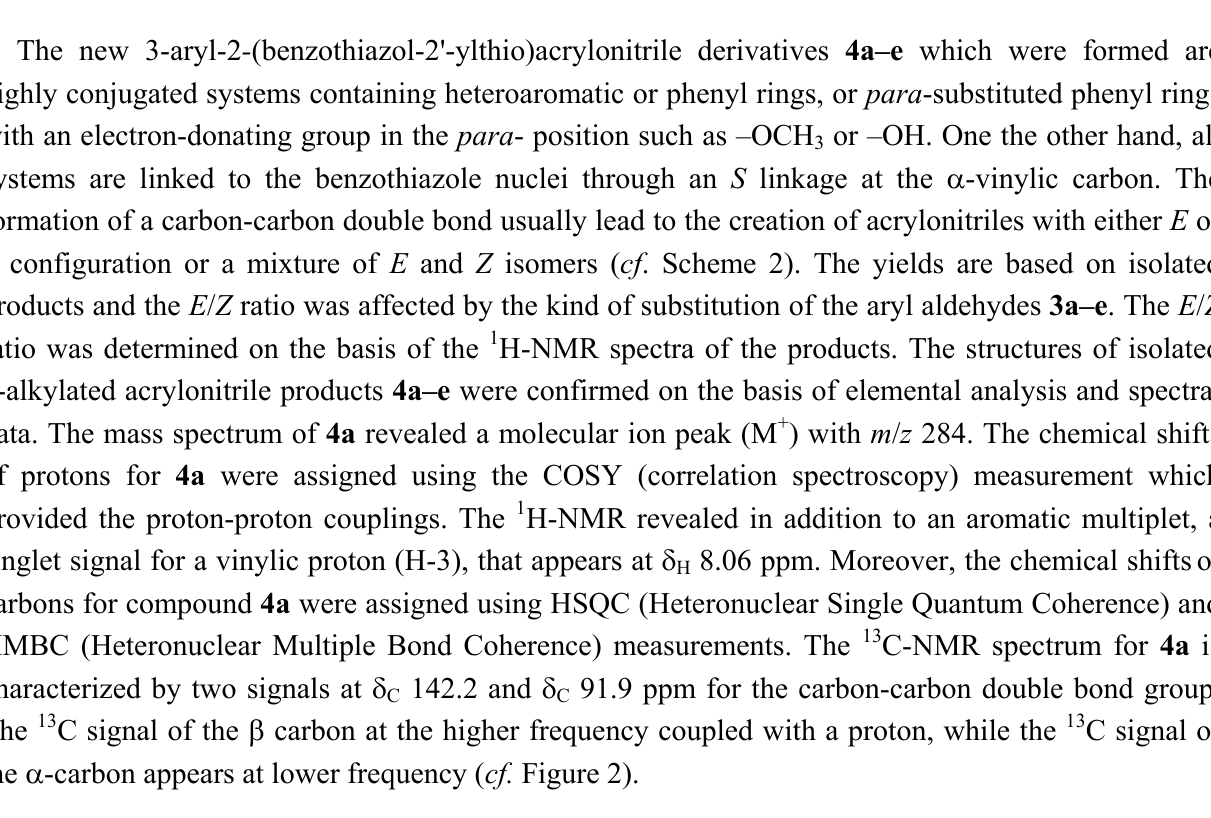
Figure 2. The complete assignment of H 1 and 13 C chemical shift for 4a based on the COSY, HSQC and HMBC